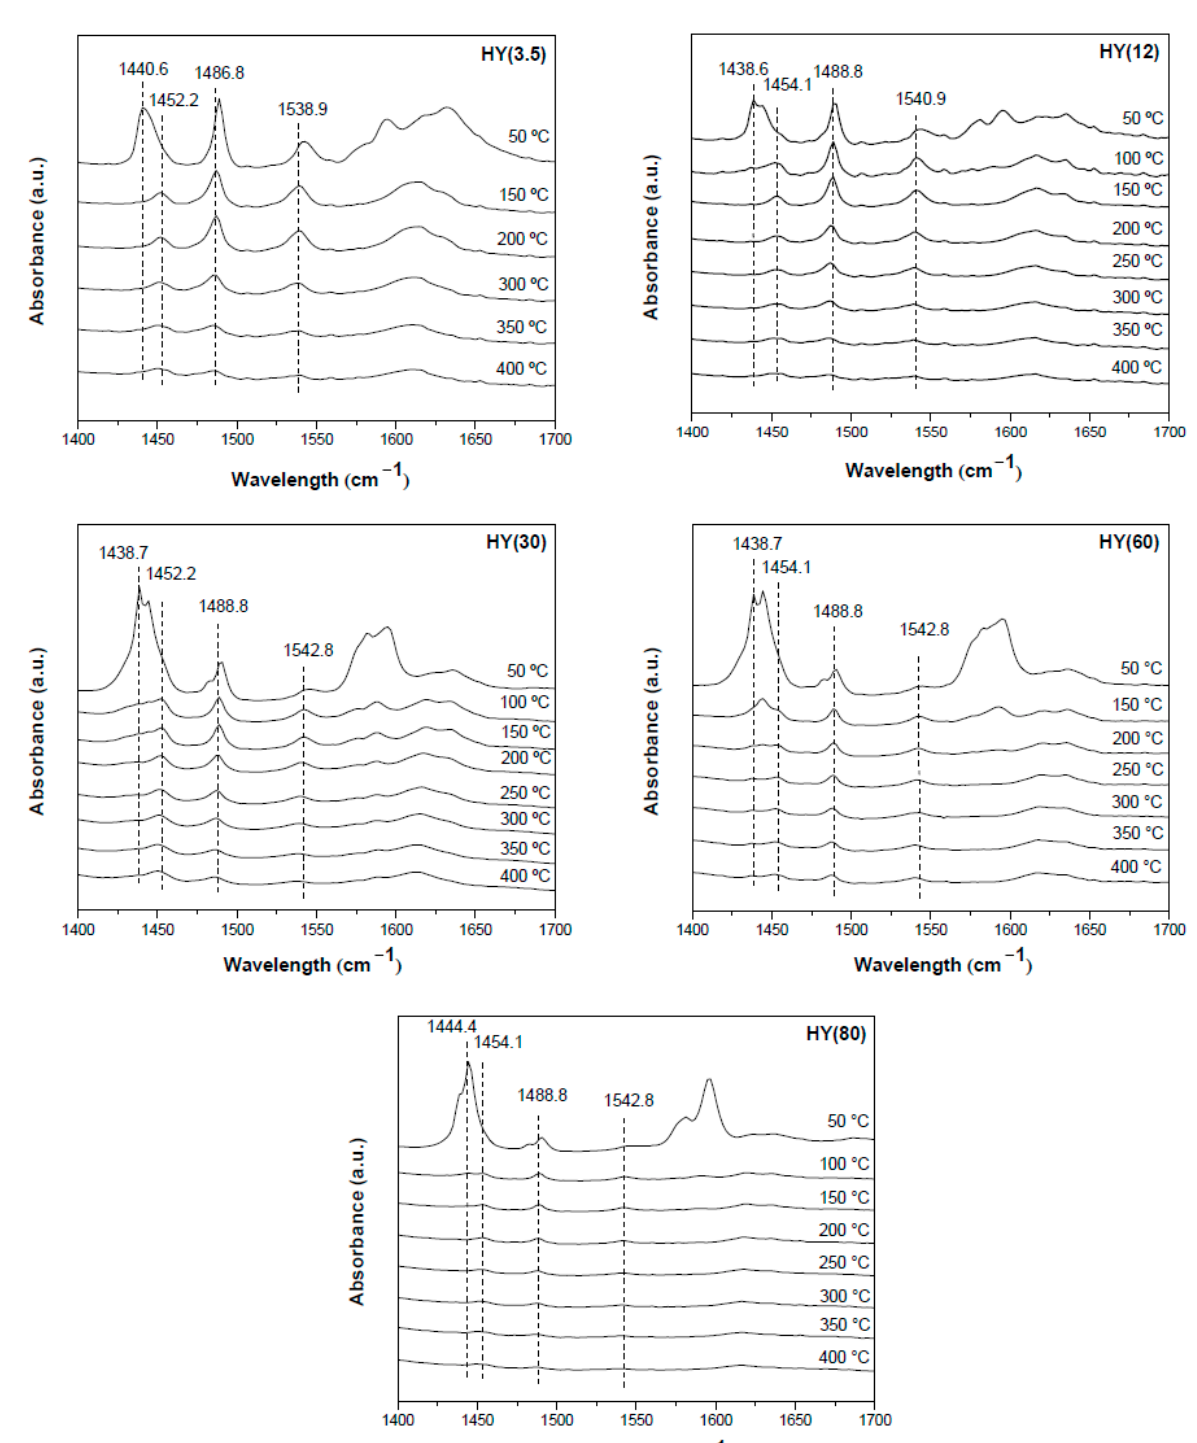
Figure 4. FTIR-Py spectra of the HY zeolites at different temperatures.